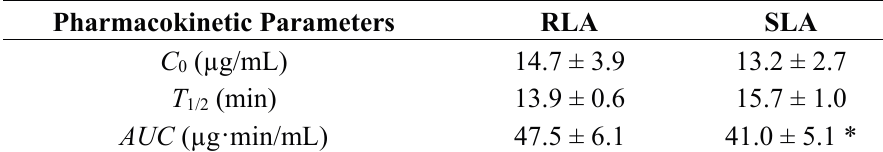
Table 4. Pharmacokinetic parameters of α -lipoic acid after intraportal administration of the racemic mixture of LA to